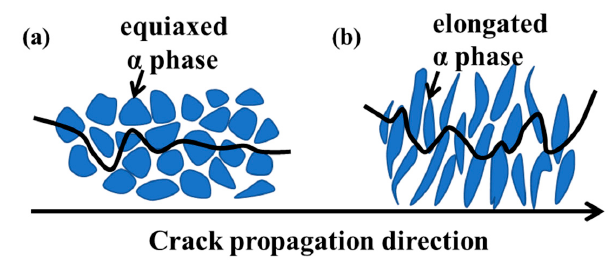
Figure 10. Schematic of the e ff ect of microstructure on the crack propagation behavior for the ( a ) RD-TD Figure 10. Schematic of the effect of microstructure on the crack propagation behavior for the ( a ) Figure 10. Schematic of the effect of microstructure on the crack propagation behavior for the ( a ) specimen and ( b ) RD-ND specimen. RD-TD specimen and ( b ) RD-ND specimen. RD-TD specimen and ( b ) RD-ND specimen. Figure 10. Schematic of the effect of microstructure on the crack propagation behavior for the ( a ) RD-TD specimen and ( b ) RD-ND specimen.